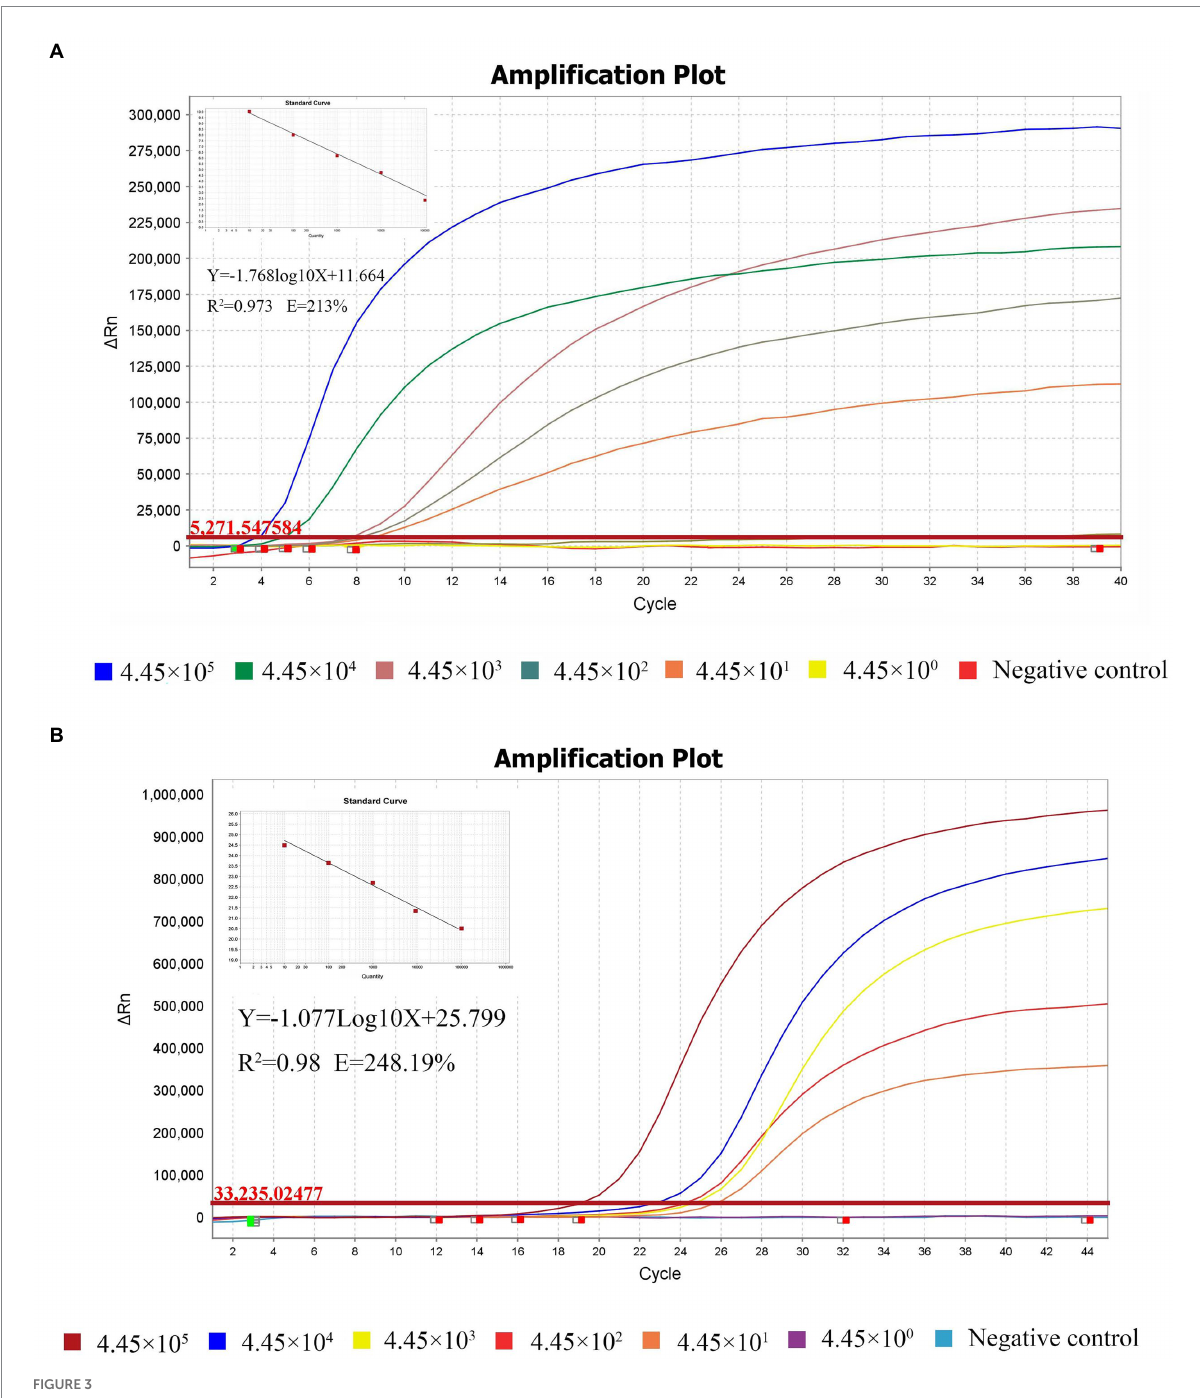
FIGURE 3 Sensitivity of the RT-qRPA method compared with the reference RT-qPCR. Analytical sensitivity of the RPA assay. Sensitivity evaluation was conducted with 10-fold dilutions of templates ranging from 4.45 × 10 5 copies/ μ L to 4.45 × 10 0 copies/ μ L. The LOD of both assays was 4.45 × 101 copies/ μ L (A, B)